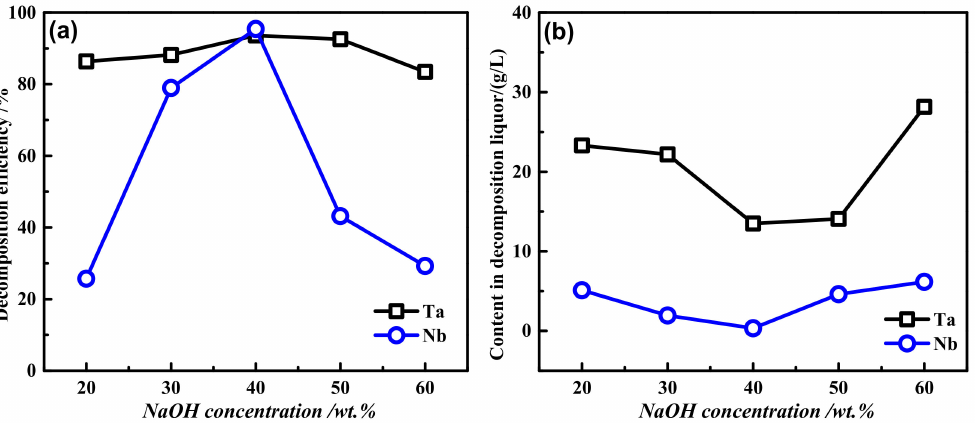
Figure 8. The effect of different alkalinities on the decomposition efficiencies ( a ) and dissolution ( b ) of tantalum niobium: reaction temperature 200 ◦ C, liquid–solid ratio 4:1, oxygen partial pressure 2.5 MPa, and reaction time